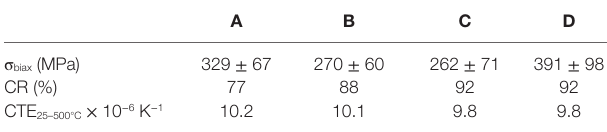
TaBle 5 | Properties of the